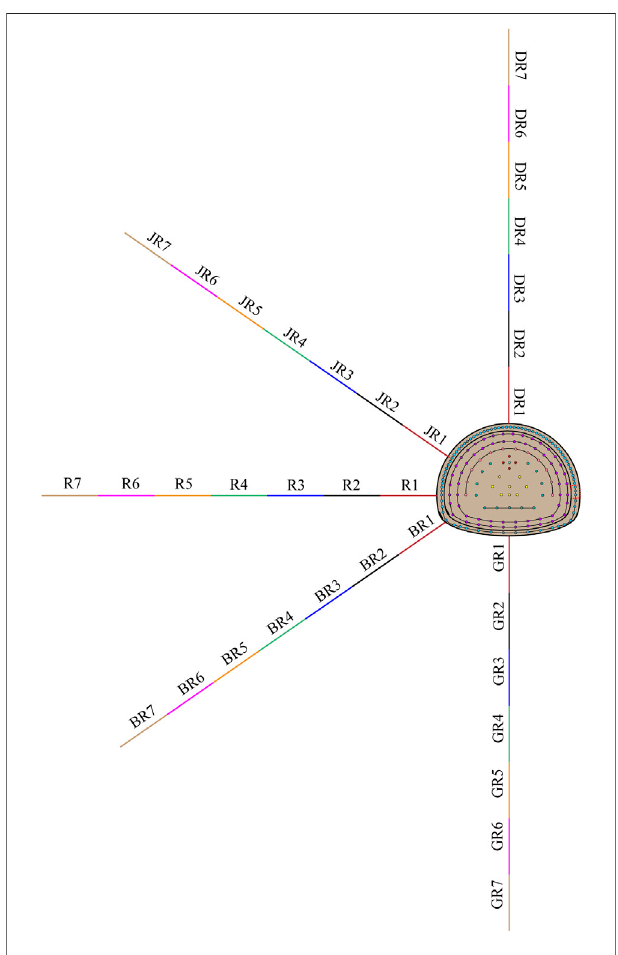
FIGURE 6 | Distribution of measuring